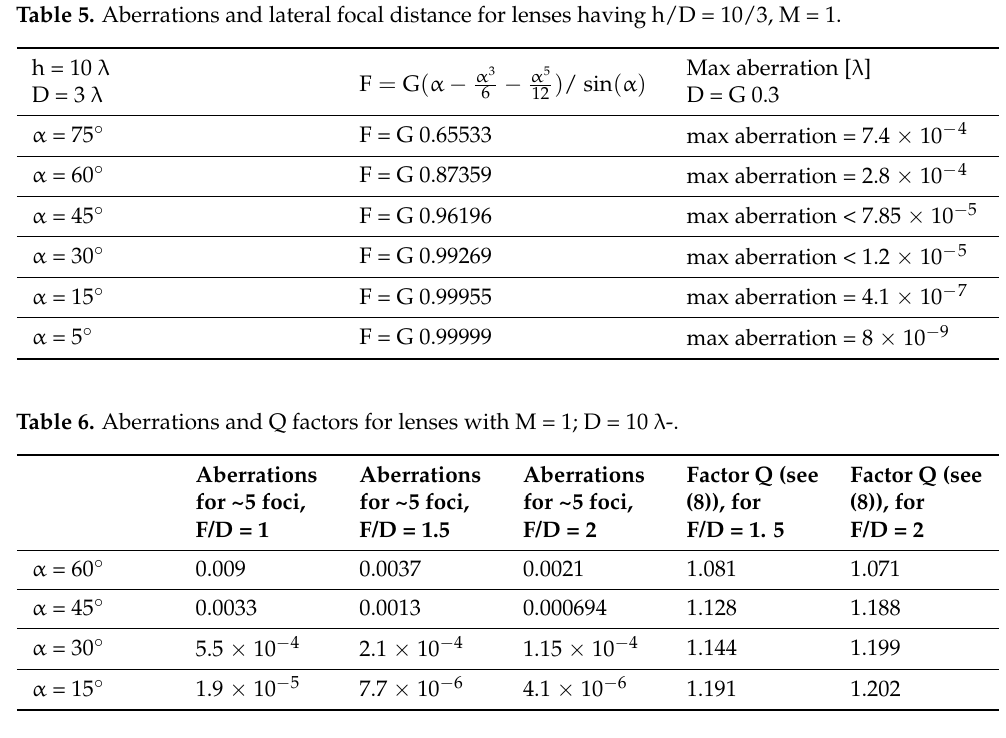
Table 6. Aberrations and Q factors for lenses with M = 1; D = 10 λ -.